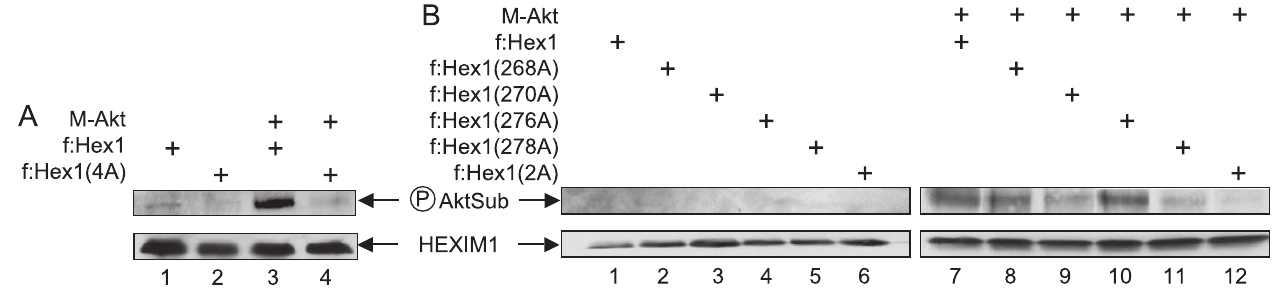
Figure 6. T270 and S278 in the TBD of HEXIM1 Are Phosphorylated following the Activation of Akt In Vivo f:Hex1 protein and mutant f:Hex1(4A) protein in (A), and mutant f:Hex1(268A), f:Hex1(270A), f:Hex1(276A), or f:Hex1(278A) proteins in (B) were expressed in Jurkat cells transfected with an empty plasmid vector or a vector expressing M-Akt. After 24 h, protein extracts were subjected to immunoprecipitation using anti-Flag antibodies, and levels of phospho-Akt substrates (pAktSub) and Flag-tagged expressed proteins were measured by western